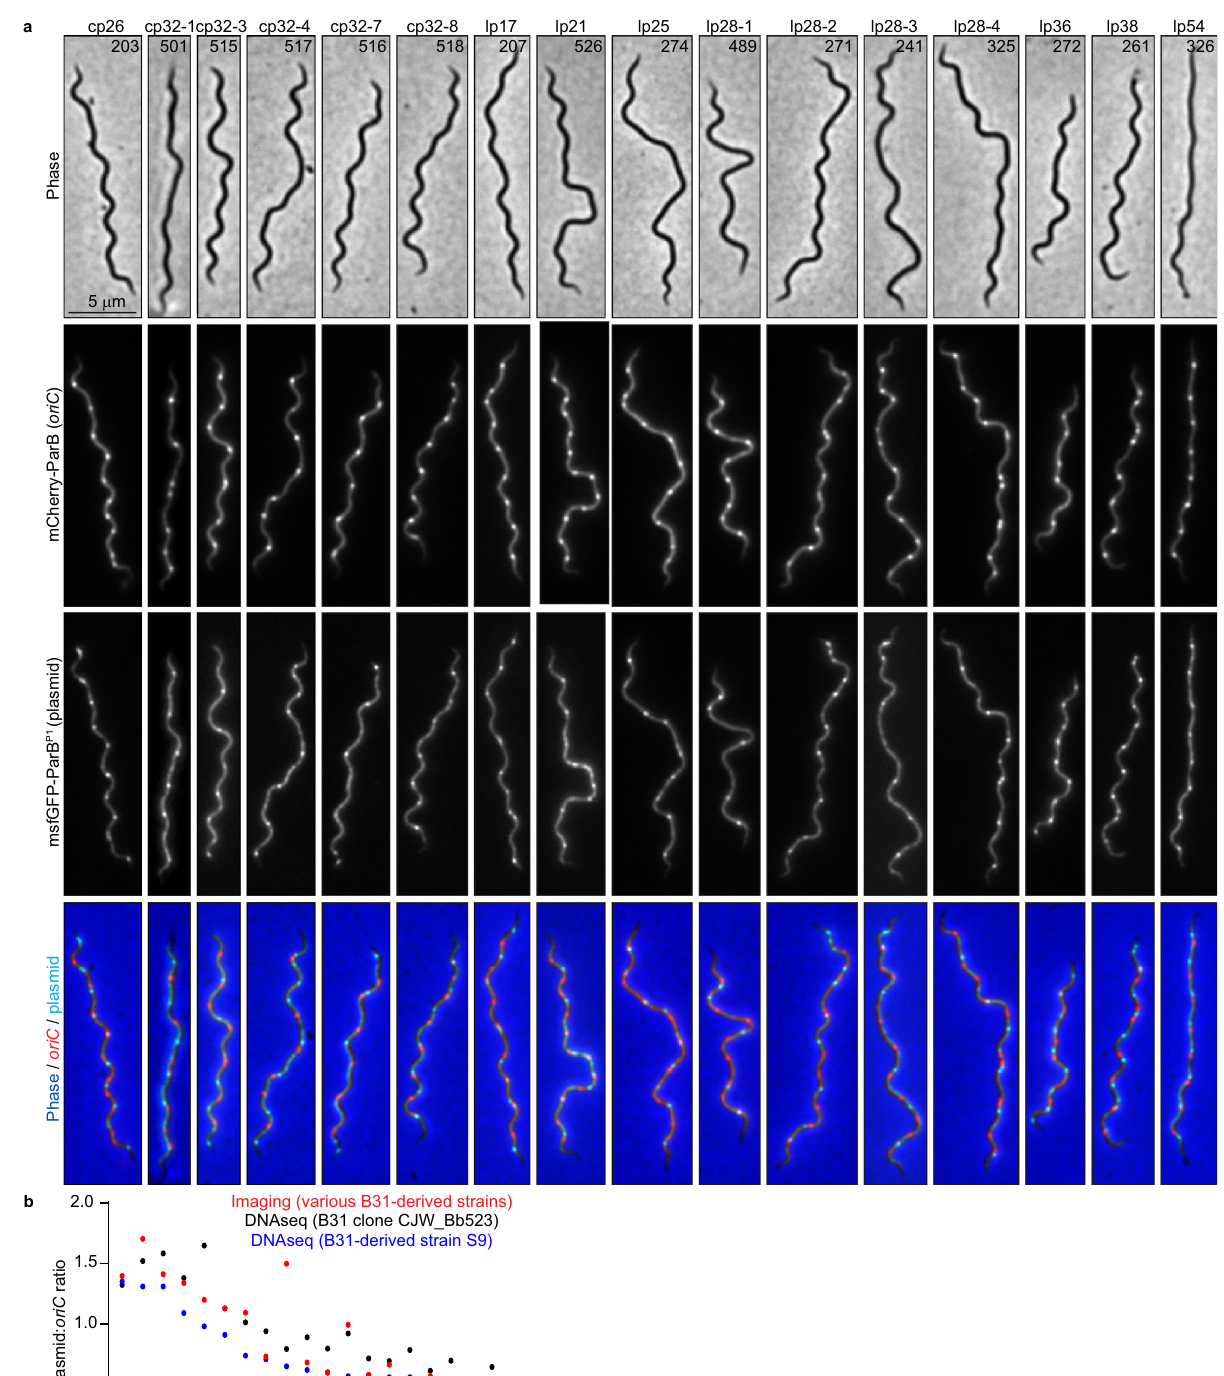
Fig. 2 | Exponentially growing B. burgdorferi cultures contain multiple copies per cell oftheir endogenous plasmids. a Images of representative cells of strains inwhichthe oriC lociwerelabeledbyexpressionofmCherry-ParBwhiletheplasmid indicatedatthetopwaslabeledbyinsertionofa parS P1 sequenceandexpressionof msfGFP-ParB P1 . CJW_Bb strain numbers are marked on the phase-contrast images. b Plot showing the plasmid-to- oriC copy numberratios determined by imaging the